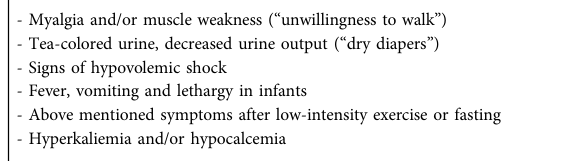
TABLE 1 Clinical suspicion for rhabdomyolysis ( “ red fl ags ” ) that should prompt evaluation of CK. - Myalgia and/or muscle weakness ( “ unwillingness to walk ” ) - Tea-colored urine, decreased urine output ( “ dry diapers ” ) - Signs of hypovolemic shock - Fever, vomiting and lethargy in infants - Above mentioned symptoms after low-intensity exercise or fasting - Hyperkaliemia and/or